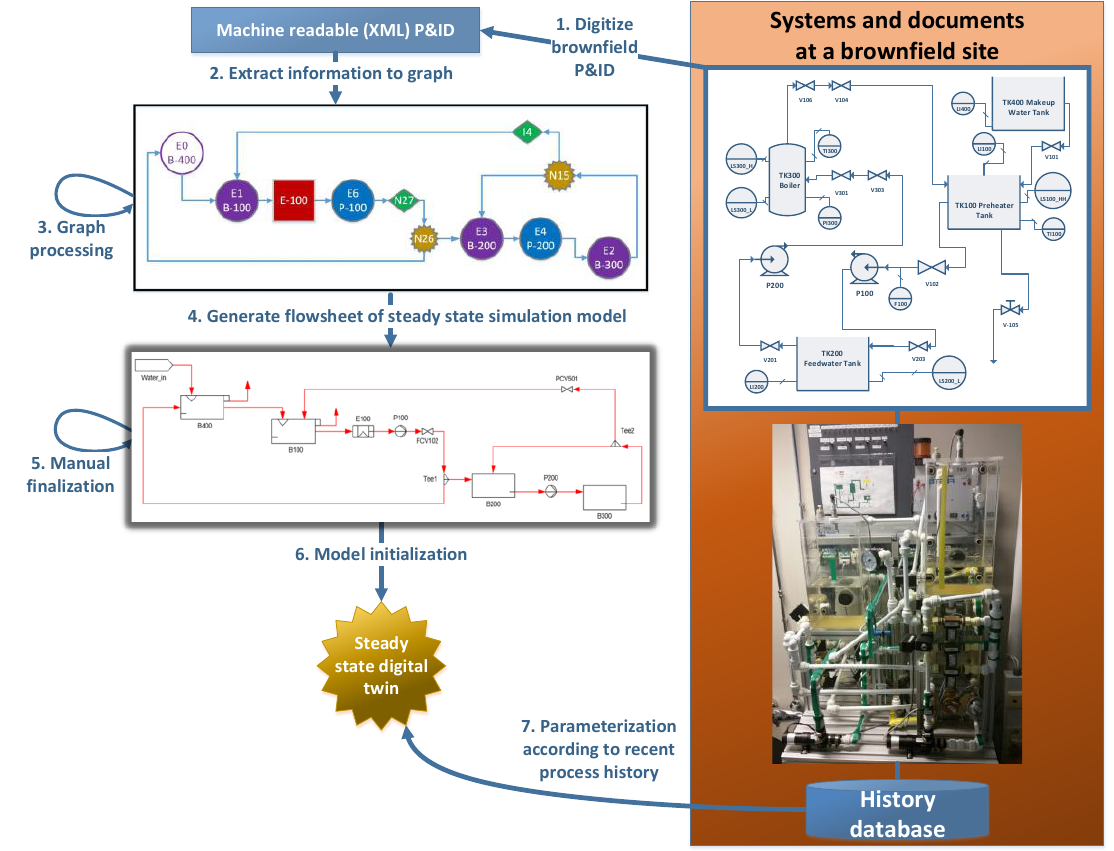
Figure 1. Proposed methodology for the semi-automatic generation of a steady state digital twin for a brownfield plant.